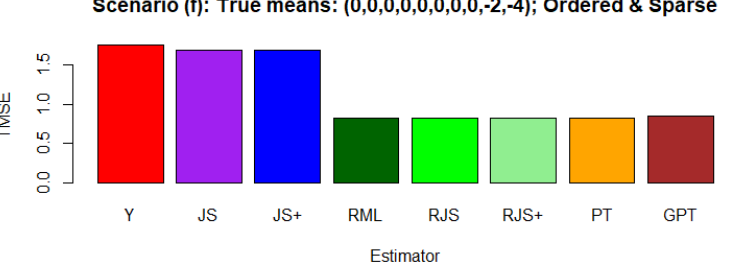
Figure 3. Simulation results for the estimators Y , δ JS , δ JS + , δ RML , δ RJS , δ RJS + , δ PT , and δ GPT . Com- parison is based on Monte Carlo average: TMSE ≡ ∑ 10,000 (cid:4674)∑ (cid:3435)𝛿 (cid:3036) (cid:3435)𝒀 ((cid:3045)) (cid:3439) − 𝜇 (cid:3036) (cid:3439)